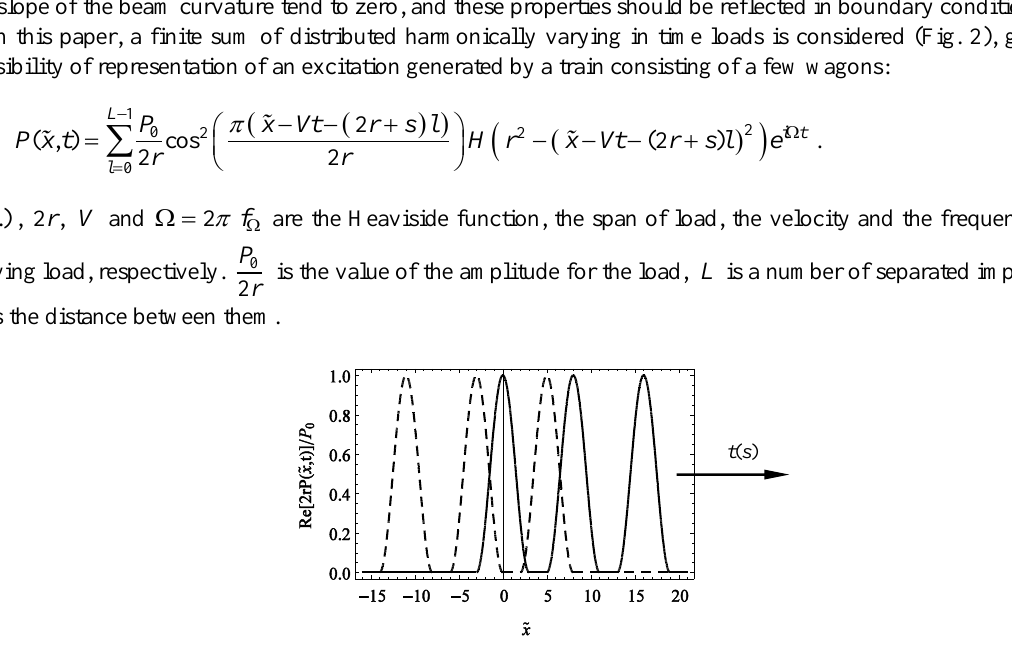
Fig. 2. The series of distributed harmonic loads for 2 s  m,